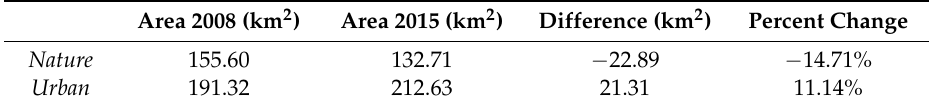
Table 1. Land use/landcover changes (LULCCs) in Philadelphia from 2008 to 2015 in km 2 . Nature includes tree canopy, grass, and bare soil. Urban includes roads, other paved surfaces, and